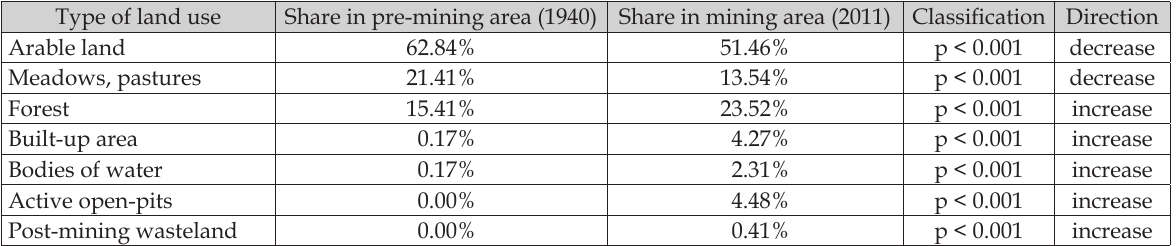
Table 1. The share of particular types of land use in the structure of the pre-mining and mining Adamów-Koźmin area.